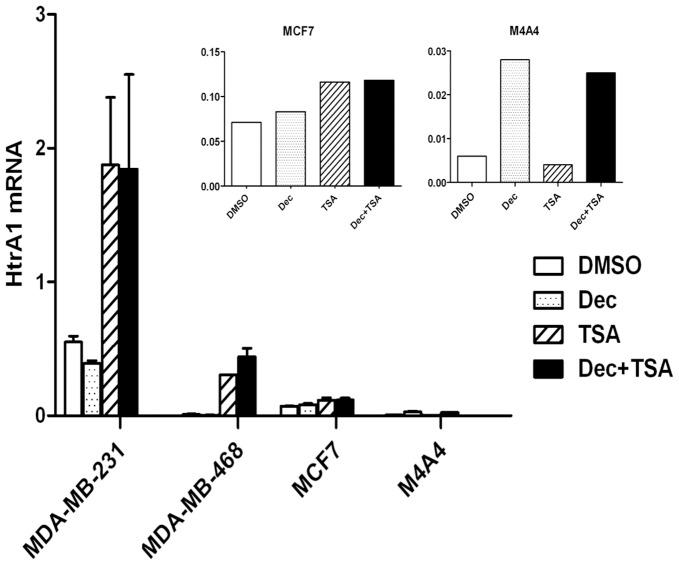
Effects of DNA methyltransferase and histone deacetylase inhibitors on HtrA1 transcript levels in human breast cancer cell lines.The indicated cell lines were treated with the DNA methyltransferase inhibitor decitabine (DEC) and/or with the histone deacetylase inhibitor TSA, as described, and resultant effects on HtrA1 transcript levels were determined using QPCR. Values ± SEs are shown from a representative experiment, which was repeated 2 times. Values for Dec and TSA were significant at p<0.01 for the MDA-MB-231 and −468 cell lines. Inset shows an expanded view of the MCF7 and M4A4 results.